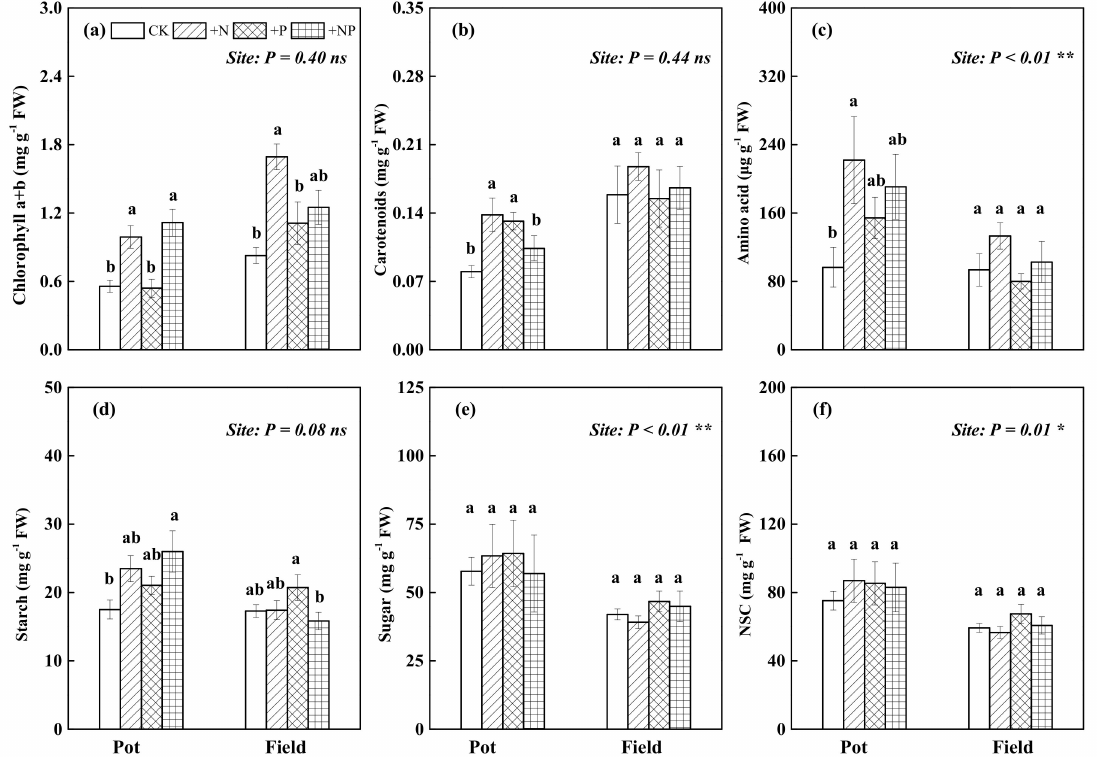
Figure 4. Leaf concentrations of chlorophyll a + b ( a ), carotenoids ( b ), amino acid ( c ), starch ( d ), sugar ( e ), and NSC ( f ) of Schima superba under field and pot experimental nitrogen and phosphorus addition (CK = control, +N = nitrogen addition, +P = phosphorus addition, +NP = nitrogen plus phosphorus addition). Note: The bars indicate the standard error. The small letters indicate the differences ( p < 0.05) among the four treatments within field or pot experiments. p value indicates the difference ( p < 0.01, **; p < 0.05, *) between field and pot experiments. The bars indicate standard errors (field, n = 3; pot, n =